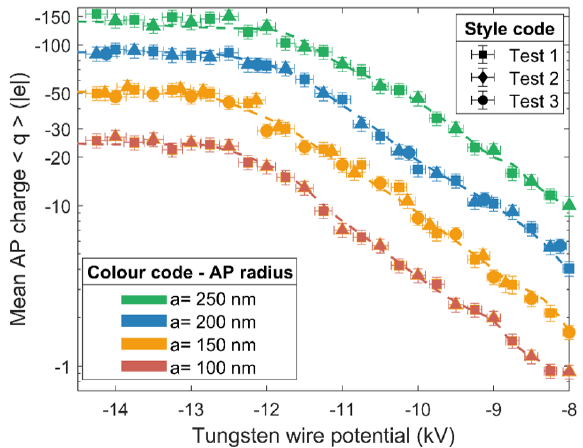
Figure 4. AP charging relationships used during experiments for the four AP radii ( a ) considered. Error bars represent the standard deviations in measurements.